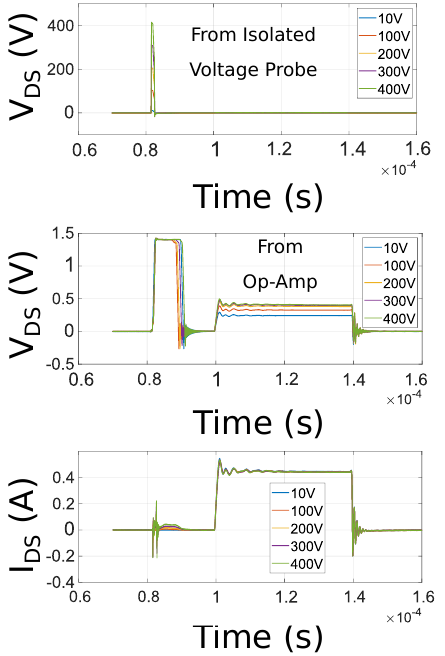
Figure 7. V DS and I DS DUT waveforms acquired by the scope for ∆ T M = 20 µ